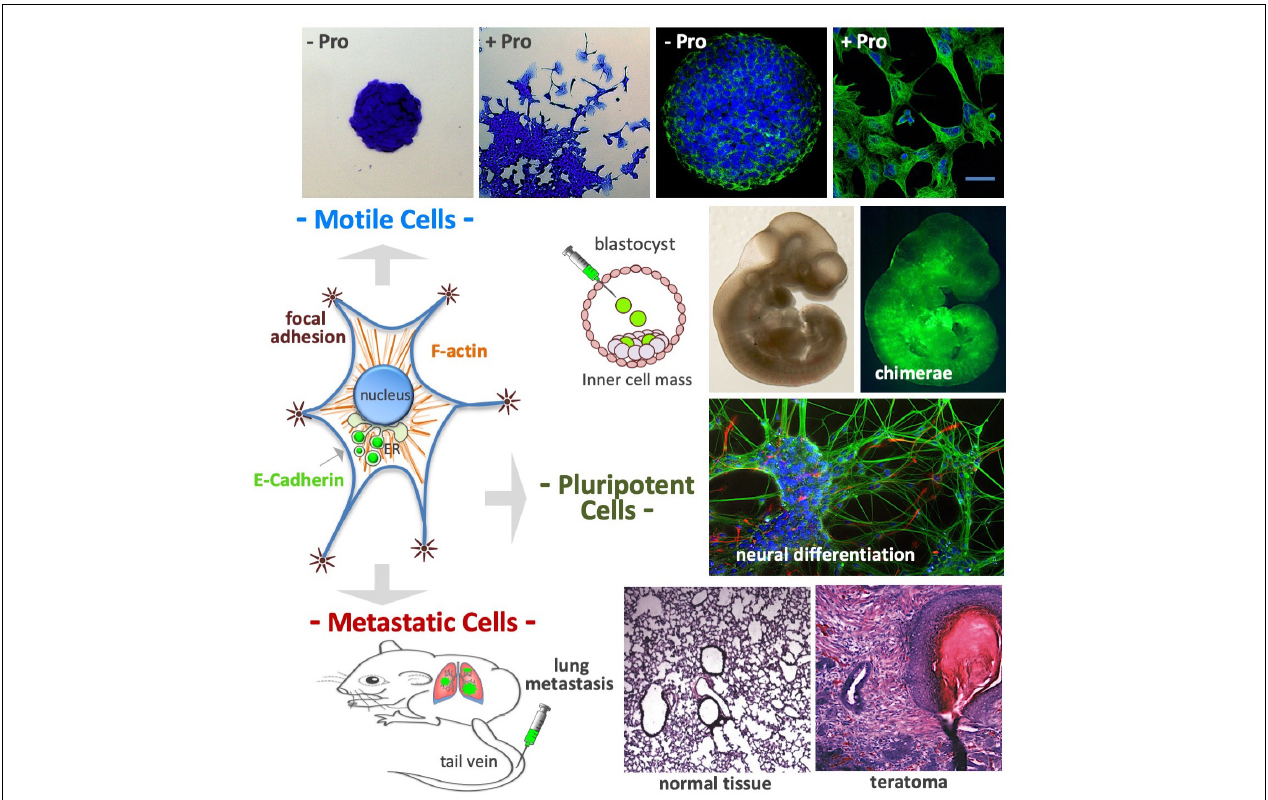
FIGURE 9 | Proline controls cell plasticity. After proline supplementation (50–150 µ M) cultured embryonic stem cells undergo a fully reversible phenotypic transition named embryonic stem-to-mesenchymal transition (esMT); after 3–4 days of incubation the cells become motile, spread out from the cell colony core ( top left ) , and display complex cytoskeleton rearrangements, with prominent actin stress fibers and focal adhesions ( top right ) . The E-cadherin protein, which is an essential component of cell-cell adherens junctions, is delocalized from the plasma membrane to the Golgi complex ( middle left ) . Even after acquiring mesenchymal features, the stem cells retain a high degree of pluripotency: (i) colonize mouse embryos after being injected in the inner cell mass of developing mouse blastocysts ( middle ) ; (ii) undergo in vitro neuronal differentiation ( middle ) and; (iii) after being injected in the tail vein of mouse ( bottom left ) , the cells reach the lungs, and after extravasation, generate metastatic teratomas, which display histologically noticeable differences from normal lung tissue ( bottom right )